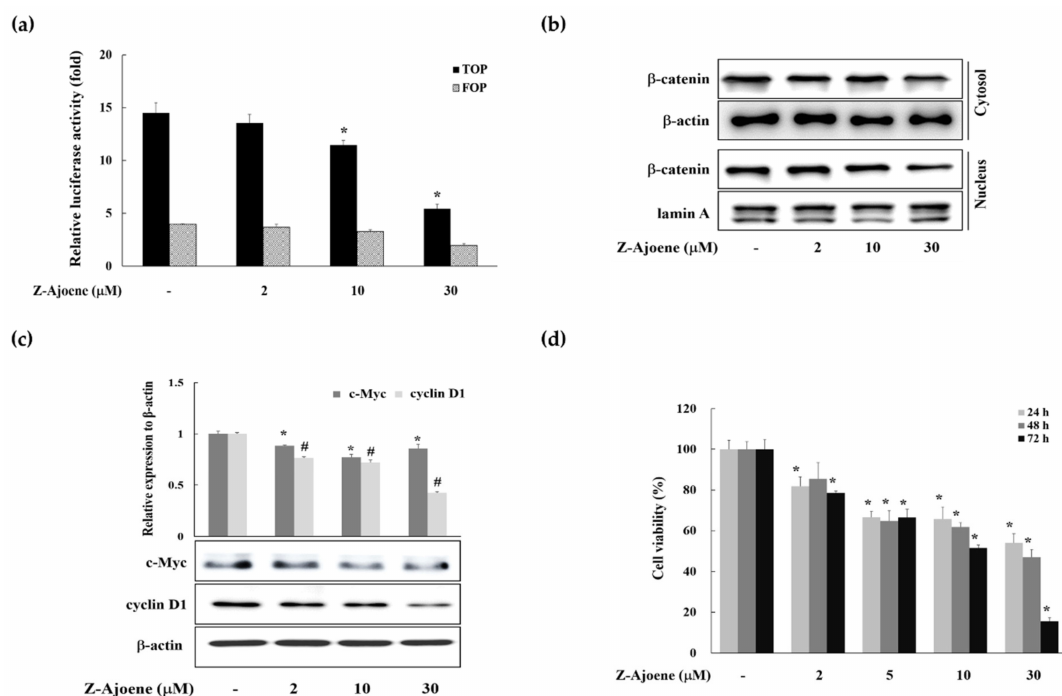
Figure 2. E ff ects of Z-ajoene on β -catenin response transcriptional activity, intracellular β -catenin levels, expressions of β -catenin target proteins, and cell proliferation in SW480 colon cancer